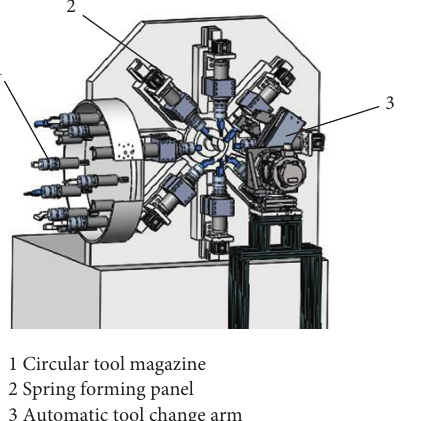
Figure 9: Schematic diagram of the spring machine with the automatic tool change system.